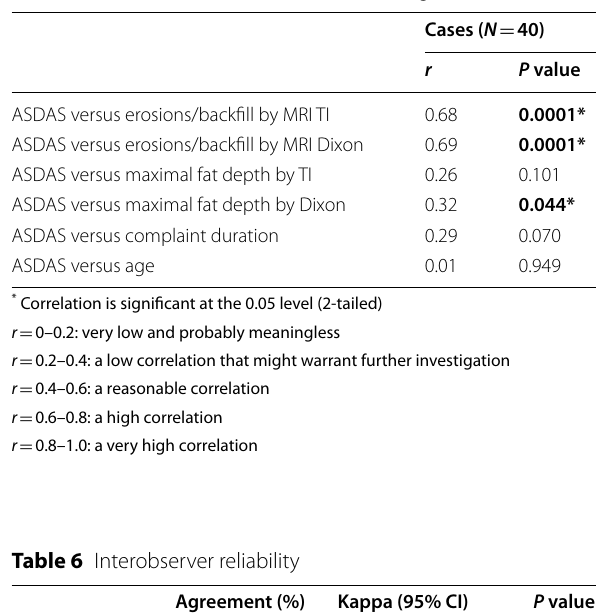
Table 5 Correlation between structural changes and ASDAS